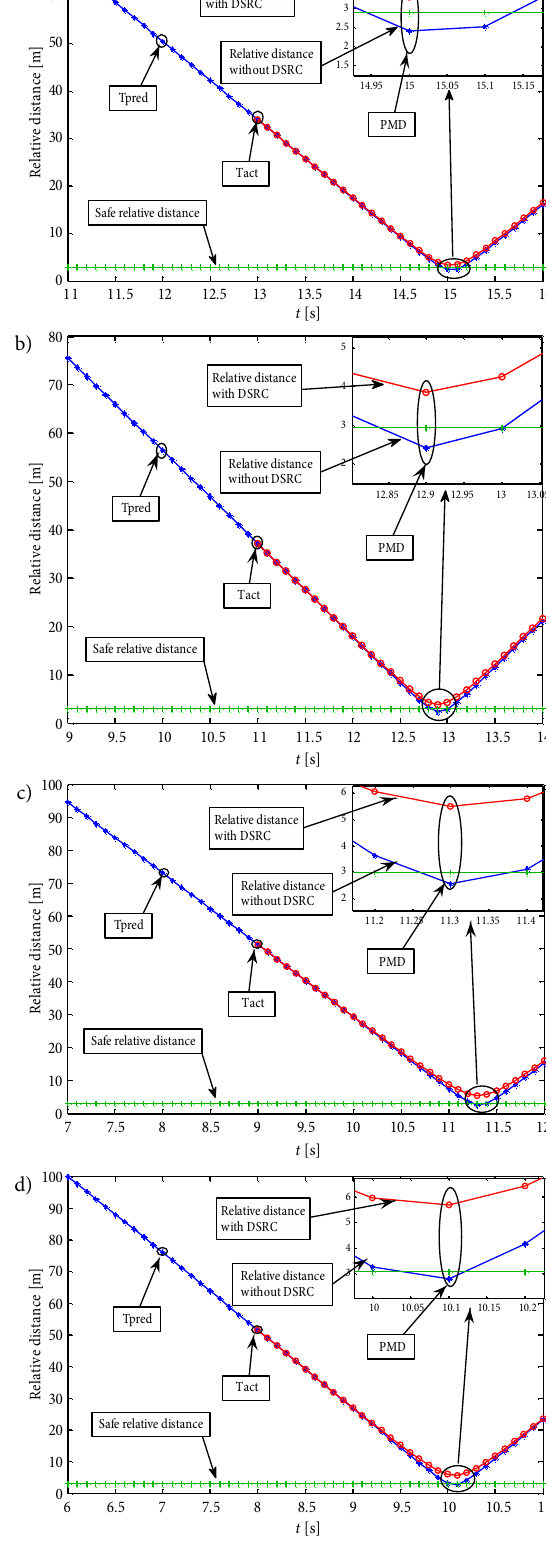
Fig. 6 Trajectories of the host and oncoming vehicles: a – v host = 30 km/h; b – v host = 40 km/h; c – v host = 50 km/h; d – v host = 60 km/h